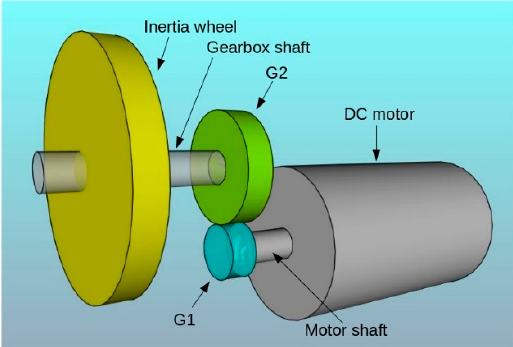
Figure 1. Components of the system to be controlled.